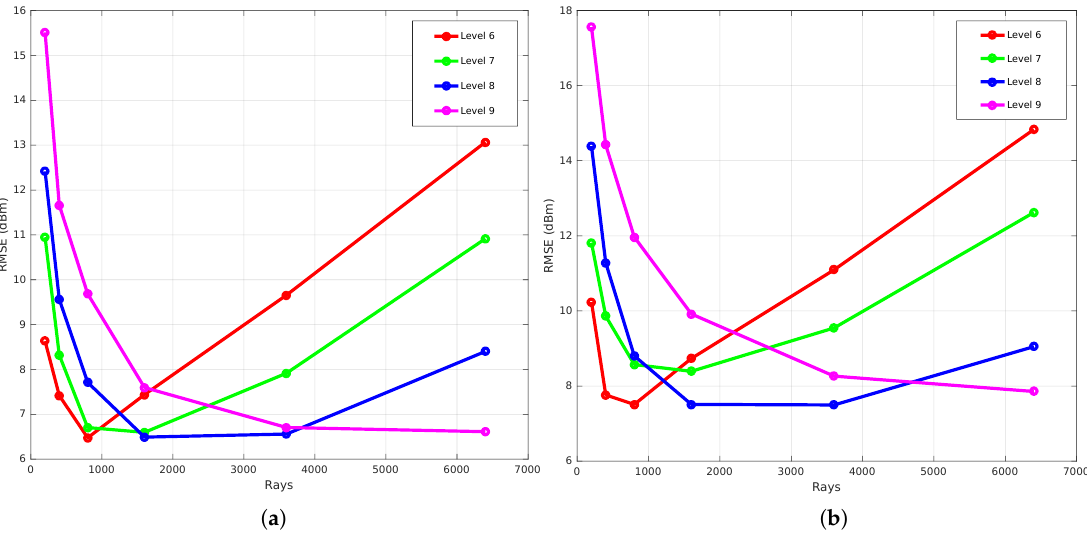
Figure 26. RMSE validation between a real environment model after SLAM and a environment based on the outer boundaries of the real environment. ( a ) RMSE validation of resolution levels (6, 7, 8, 9) of the environment model after SLAM; ( b ) RMSE validation of resolution levels (6, 7, 8, 9) of the environment model of the other